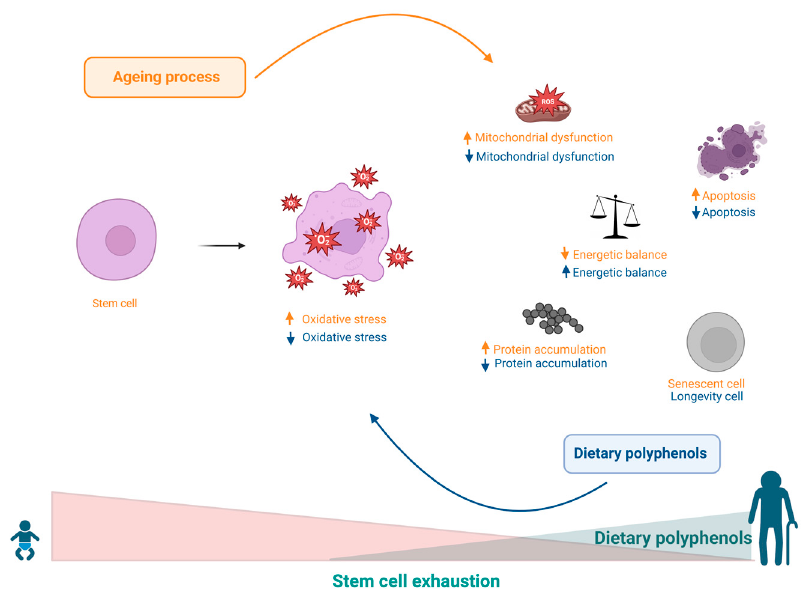
Figure 8. Increased ROS levels caused by electron spillage from the oxidative phosphorylation cascade cause local and/or systemic imbalances and changes in stem cell niches, resulting in a decreased asymmetric stem cell division rate, leading to depletion of progenitor cells, and consequently contributing to senescence. Polyphenols can benefit the regulation of virtually all events involved in the progression of ageing.